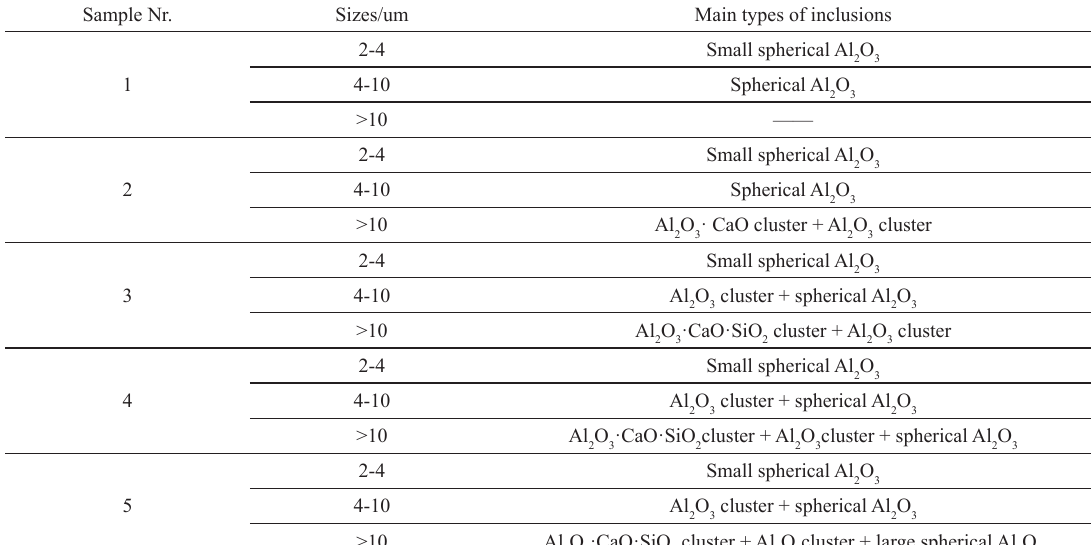
Table 6. Inclusions types of different sizes. Sample Nr.